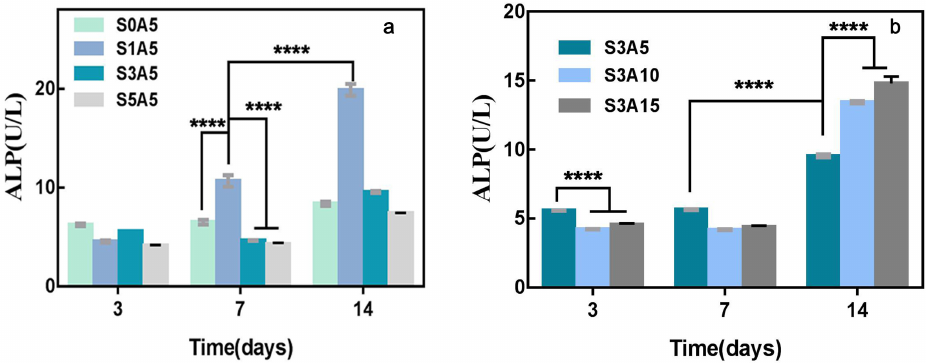
Figure 10. ALP activity of MC3T3 ‐ E1 cells cultured with dual drug ‐ loaded biomimetic composite scaffolds with different Sal ‐ B content ( a ) and different ASA content ( b ). ( n = 3, mean ± SD, **** p < 0.0001).